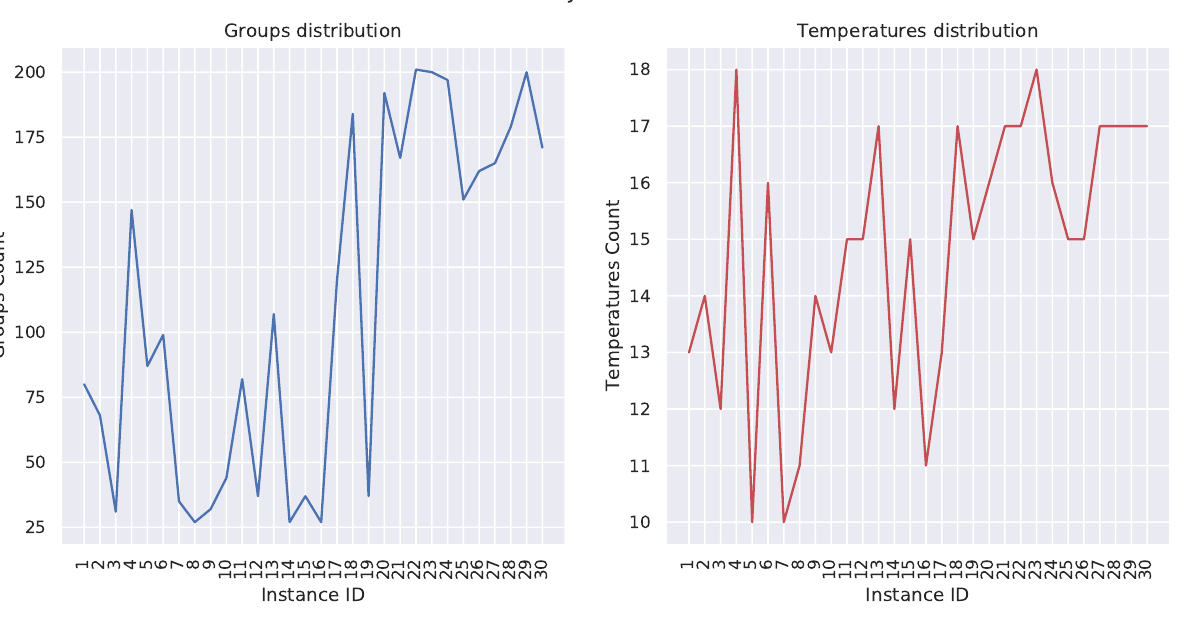
Figure 7. Summary of all 30 available data